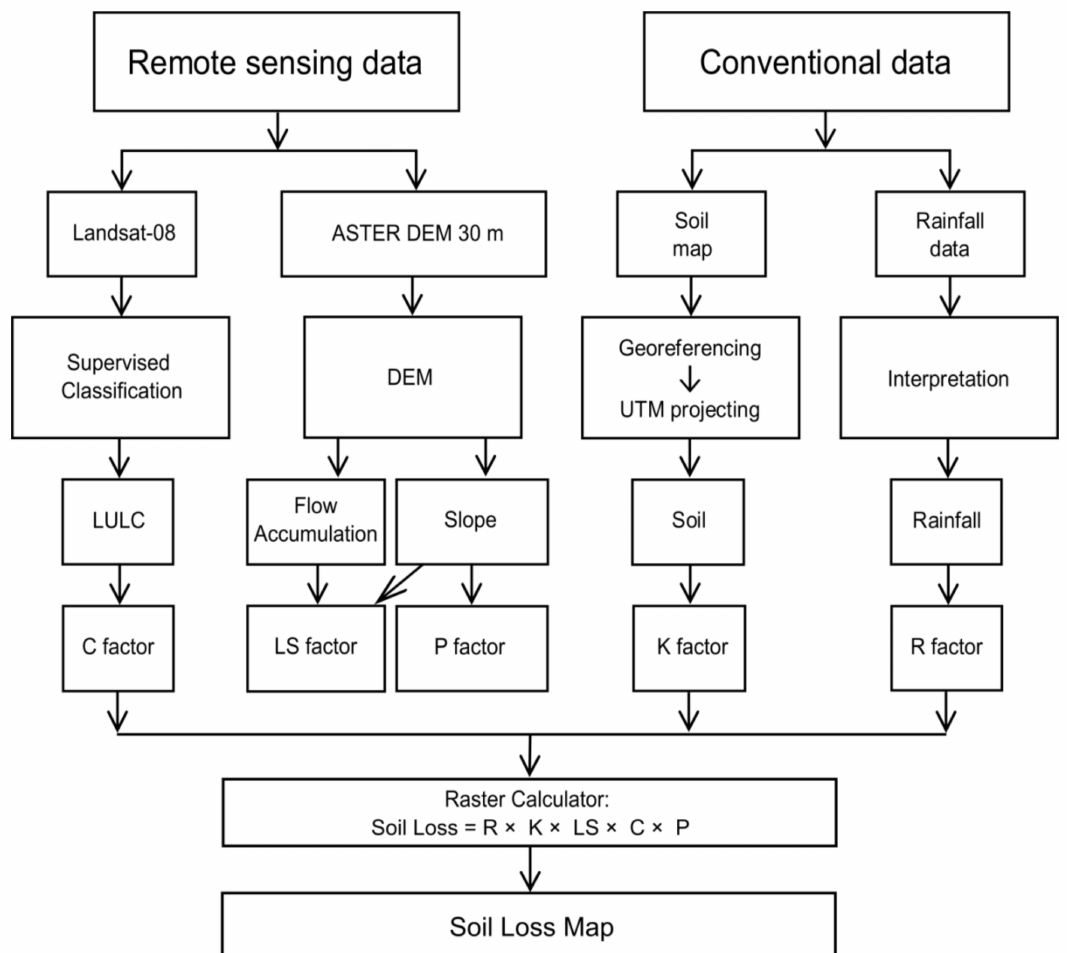
Figure 2. Flowchart of data processing for RUSLE